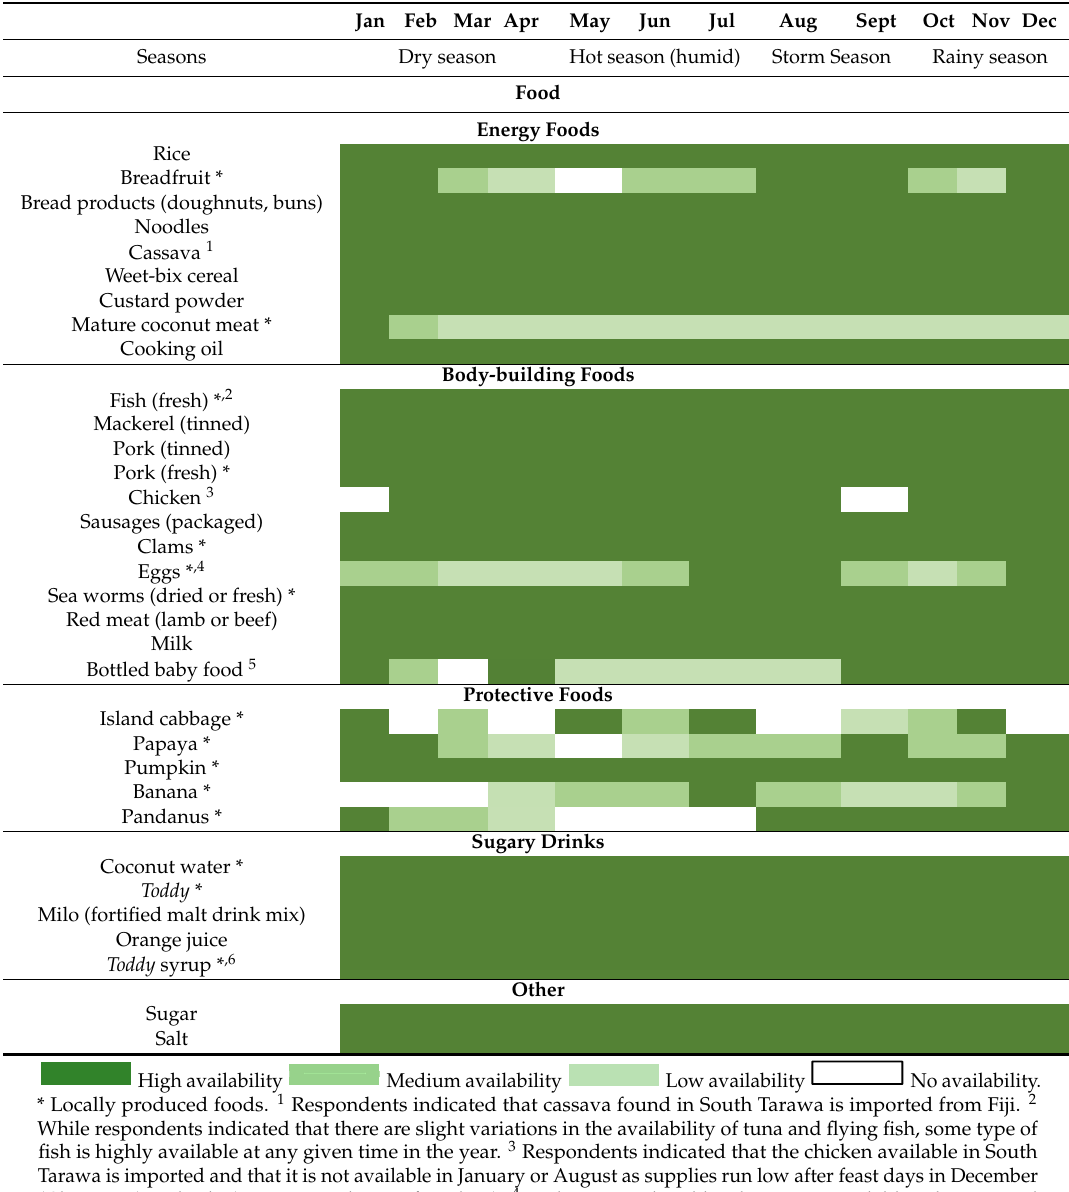
Table 4. Seasonal food availability calendar for Teaoraereke village in South Tarawa [urban].